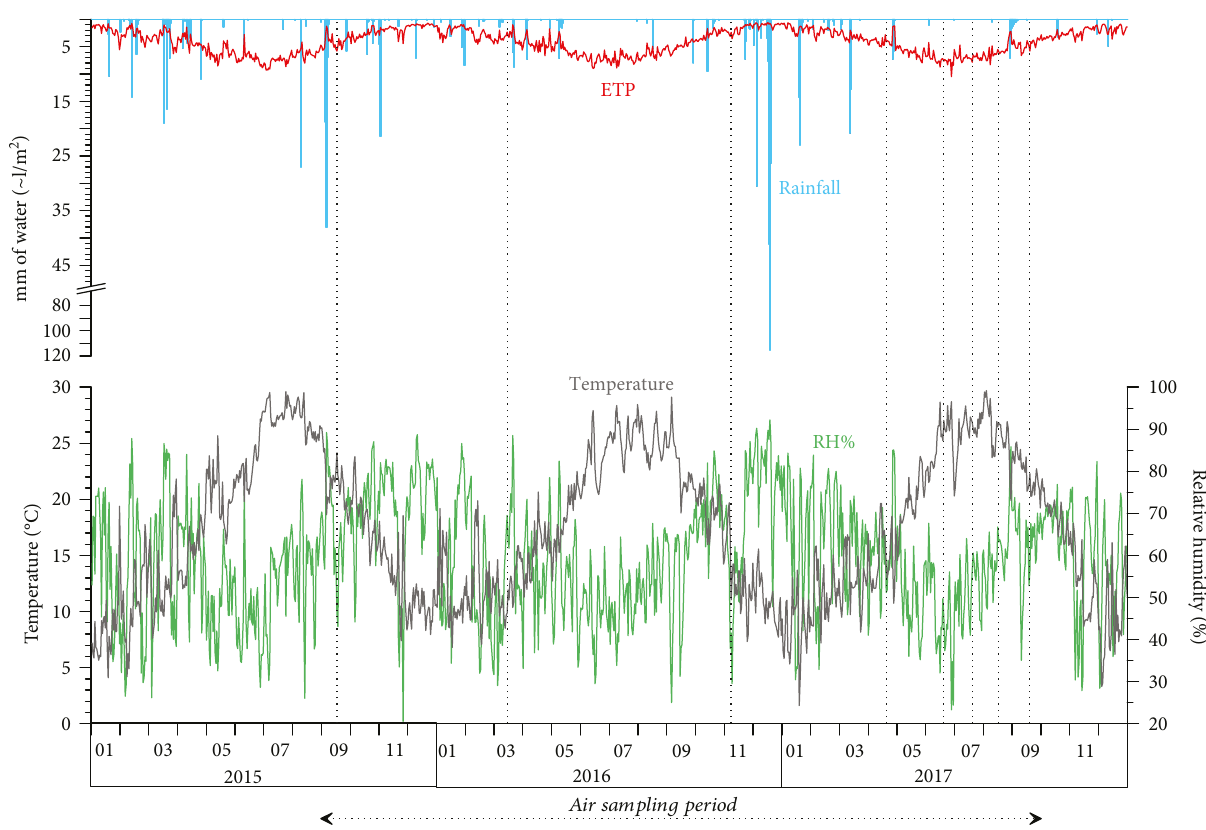
Figure 4: Daily meteorological conditions in the study area from January 2015 to December 2017, including the dates of the air sampling campaigns (dotted vertical lines). Parameters; air temperature, relative humidity, rainfall, and evapotranspiration according to the Penman-Monteith FAO parameterization scheme